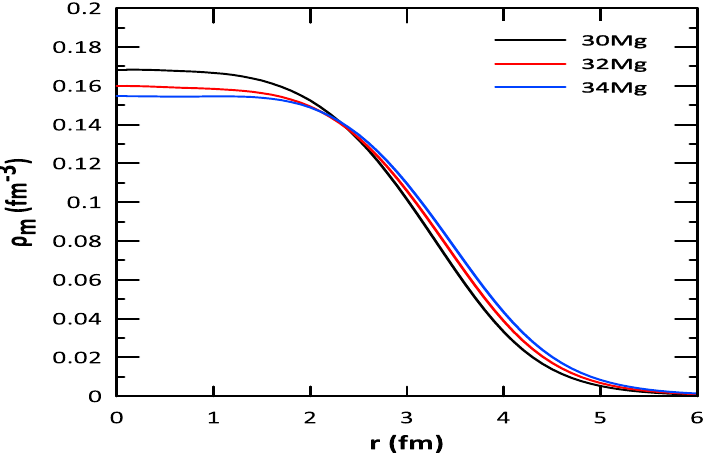
Fig. 7(b): The relation between matter density (fm -3 ) and position r(fm) for 30,32,34 Mg